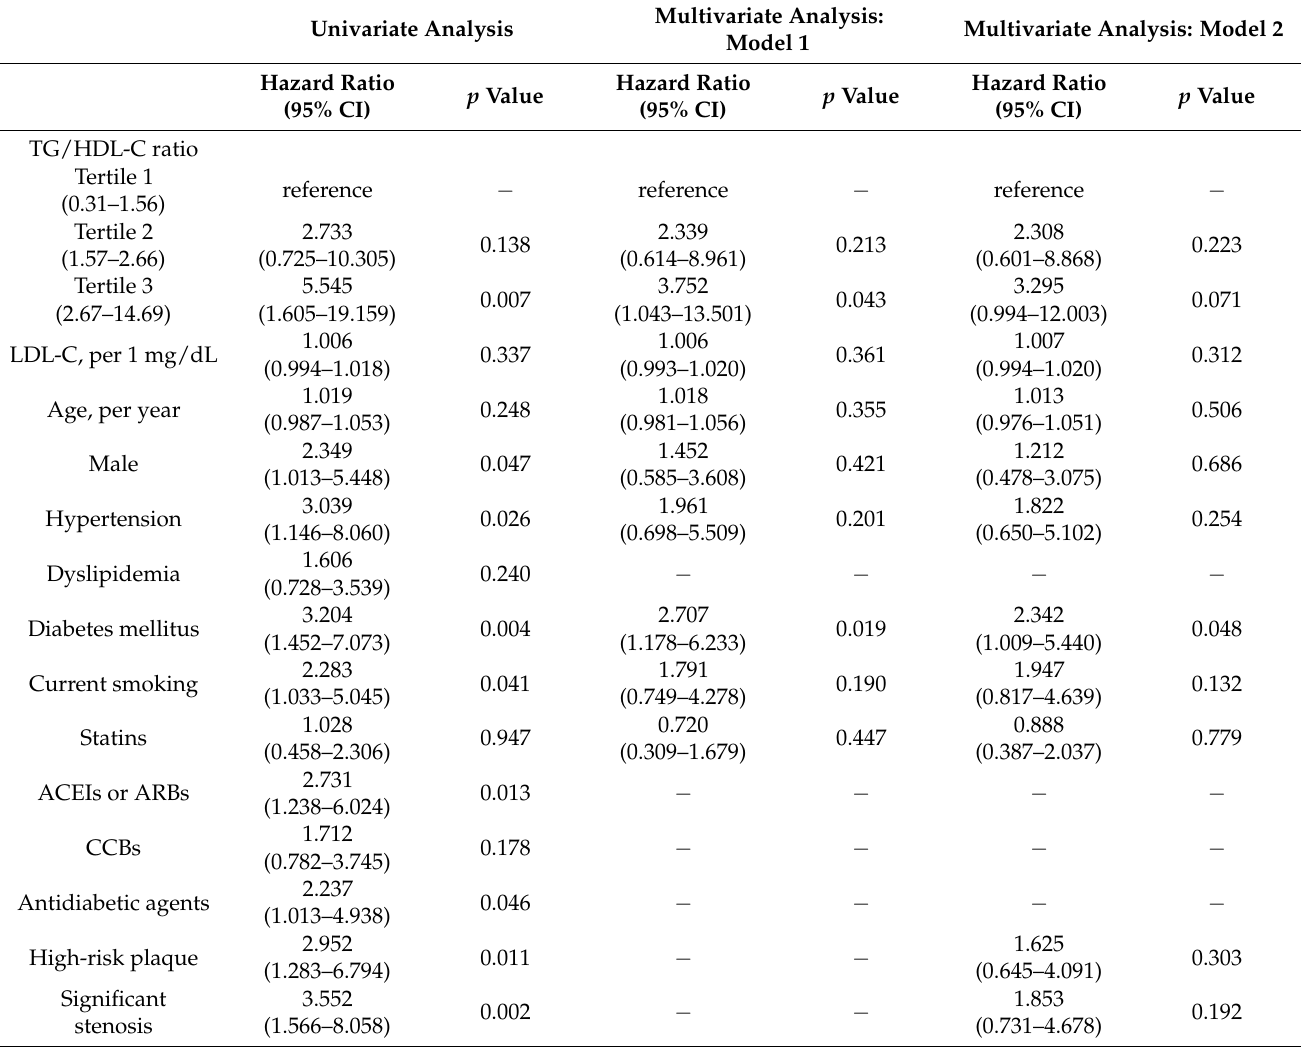
Table 5. Univariable and multivariable associates of the primary